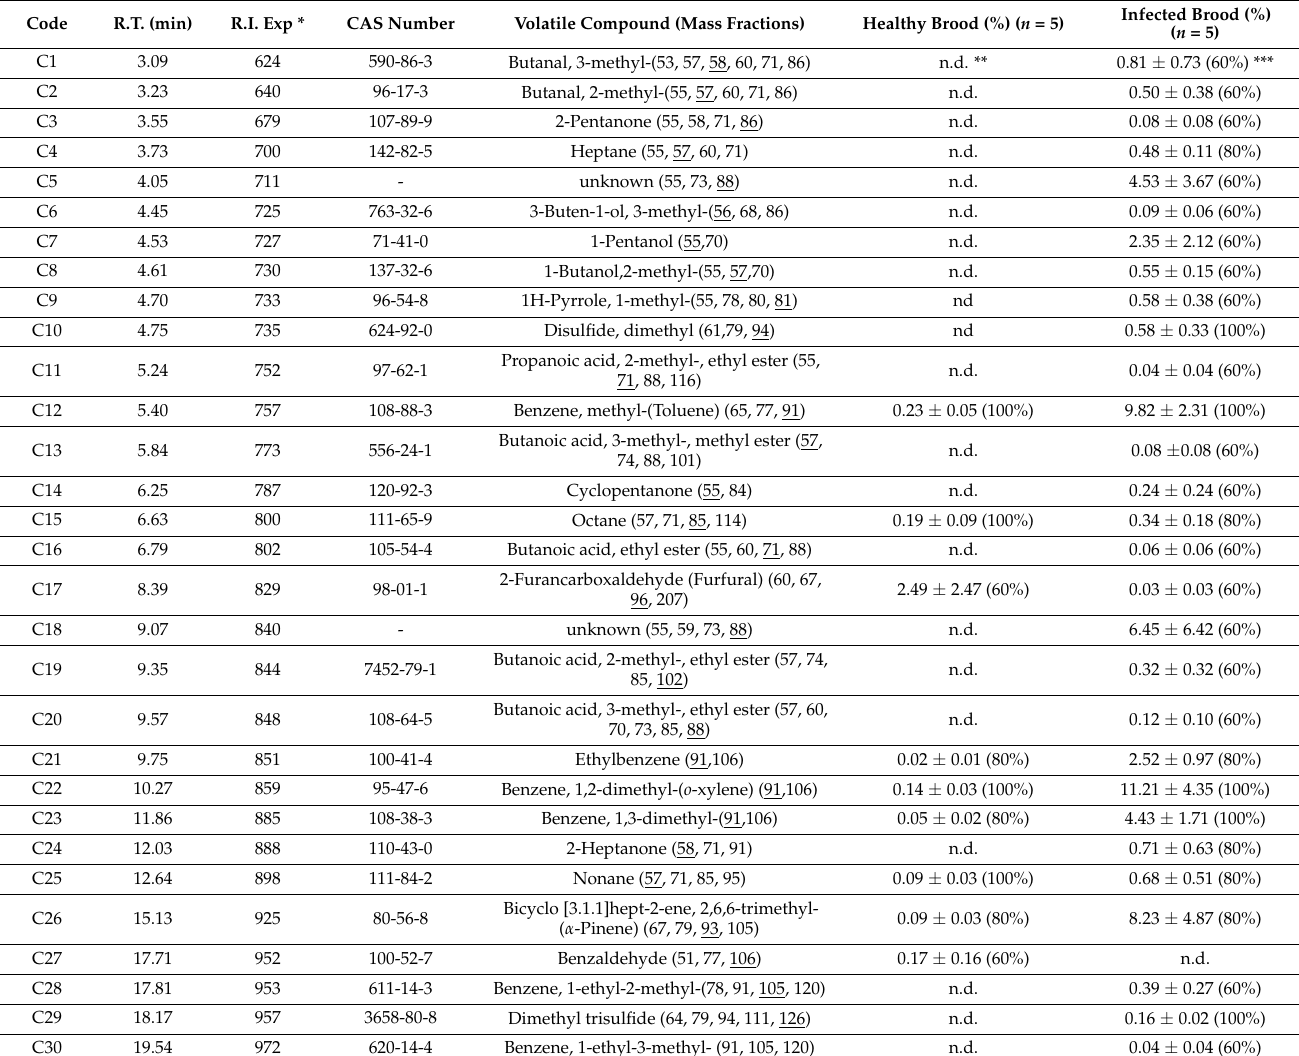
Table 2. Mean percentage of volatile compounds in healthy and unhealthy brood samples [Retention times—-R.T., mass fractions (the underlined is the major fraction), average, and standard